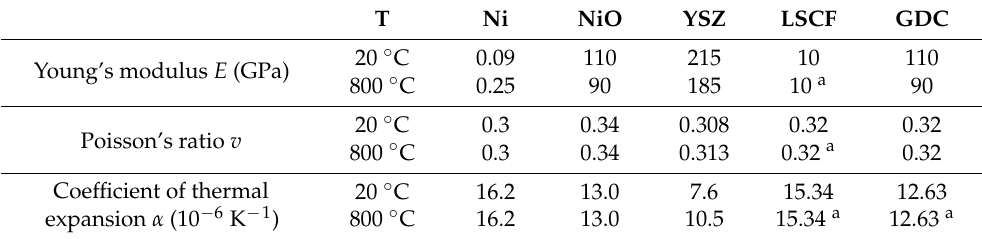
Table 3. Parameters for the thermal stress analysis of an SOFC [10,11].